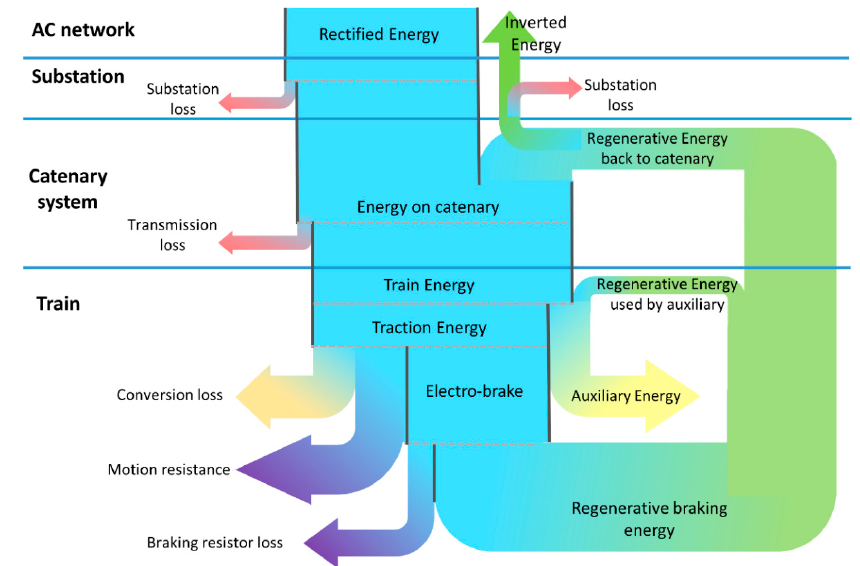
Figure 6. Typical energy flow chart of metros.